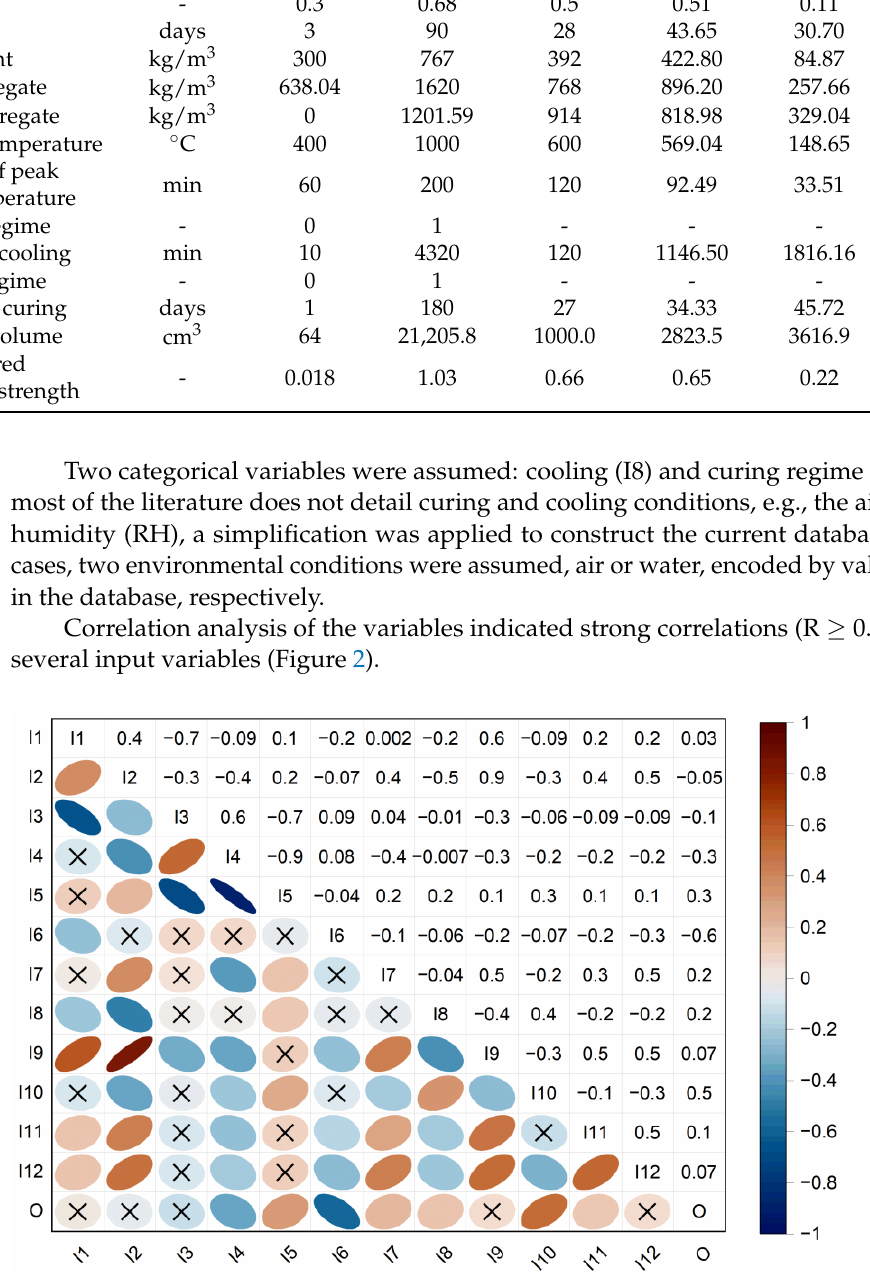
Figure 2. Correlation matrix of the input and output variables (x—statistically insignificant correlation). Concrete mix composition parameters were found to be correlated, i.e., w/c (I1) and cement amount (I3) (R = − 0.7), cement mount (I3) and coarse aggregate (I5) (R = − 0.7), and fine aggregate (I4) and coarse aggregate (I5) (R = − 0.9). In addition, a strong correlation (R = 0.9) was found between the age (I2) and cooling duration (I9)